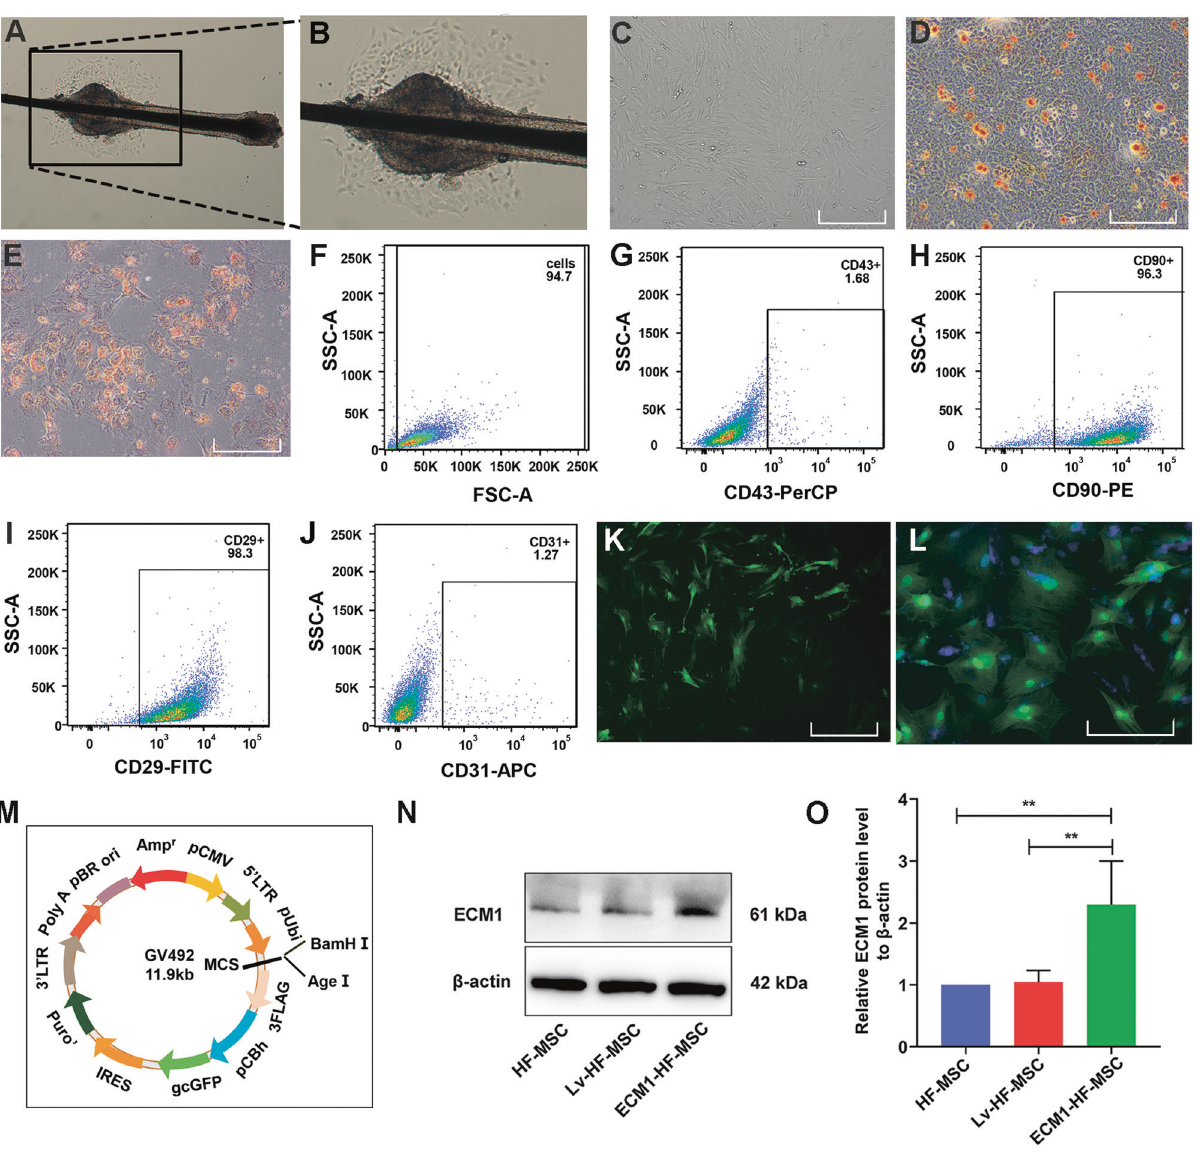
Fig. 3 Identi fi cation and transfection of HF-MSCs. Primary ( A , B ) and P3 ( C ) HF-MSCs. D , E Adipogenic and osteogenic differentiation of HF- MSCs. F – J Identi fi cation of speci fi c antigenic markers in HF-MSCs by fl ow cytometry. K The transfected HF-MSCs show green fl uorescence under a 4X microscope. L HF-MSCs expressing GFP were costained for nuclear detection and observed under a 10X microscope. M The constructed lentiviral vector containing ECM1 and GFP. N , O Immunoblotting analysis and semiquantitative analysis of ECM1 in the HF- MSC group, the LV-HF-MSC group, and the ECM1-HF-MSC group. Data are shown as the means ± SDs (* p < 0.05, ** p < 0.01, *** p < 0.001). Scale bar = 50 μ